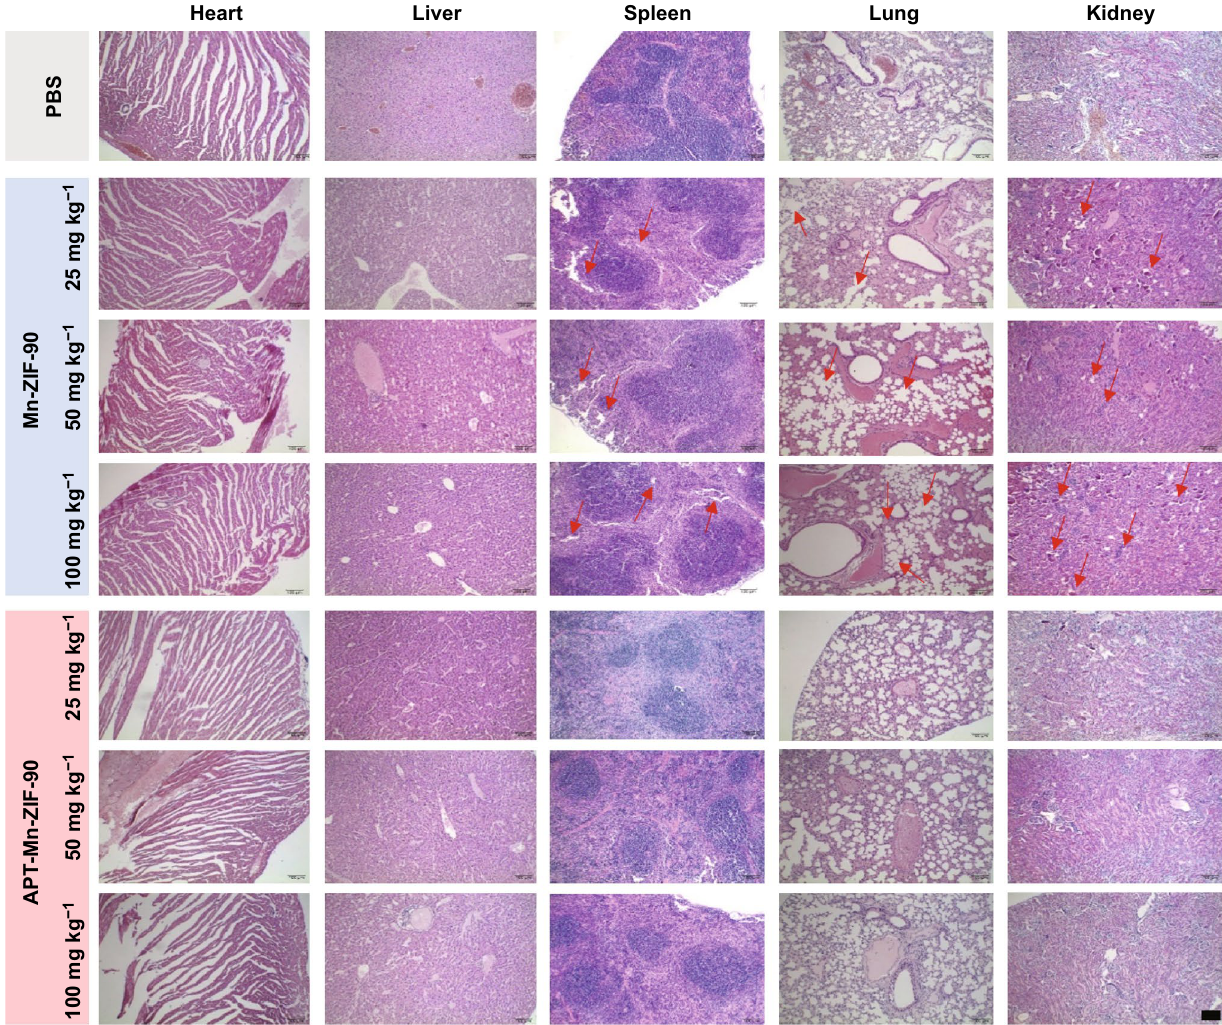
Fig. 5 H&E staining of major organs of mice 7 days post-injection of PBS and different concentrations of Mn-ZIF-90 or APT-Mn-ZIF-90. (Scale bar = 100